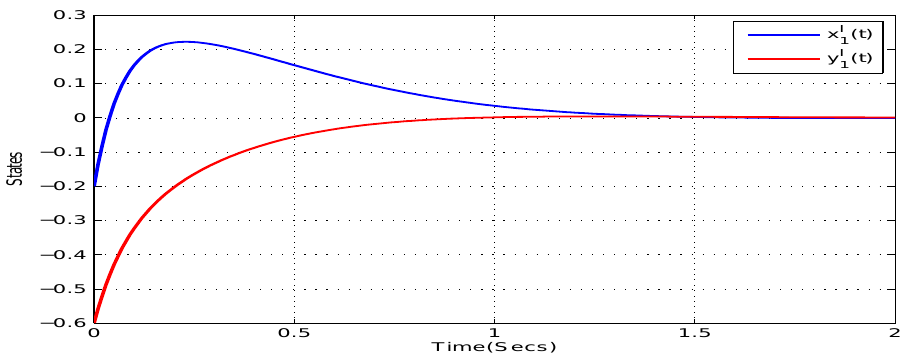
Figure 4. An illustration of the time responses with respect to the imaginary part pertaining to the states of ( t ) , y I ( t ) in Example 2. x I 1 1